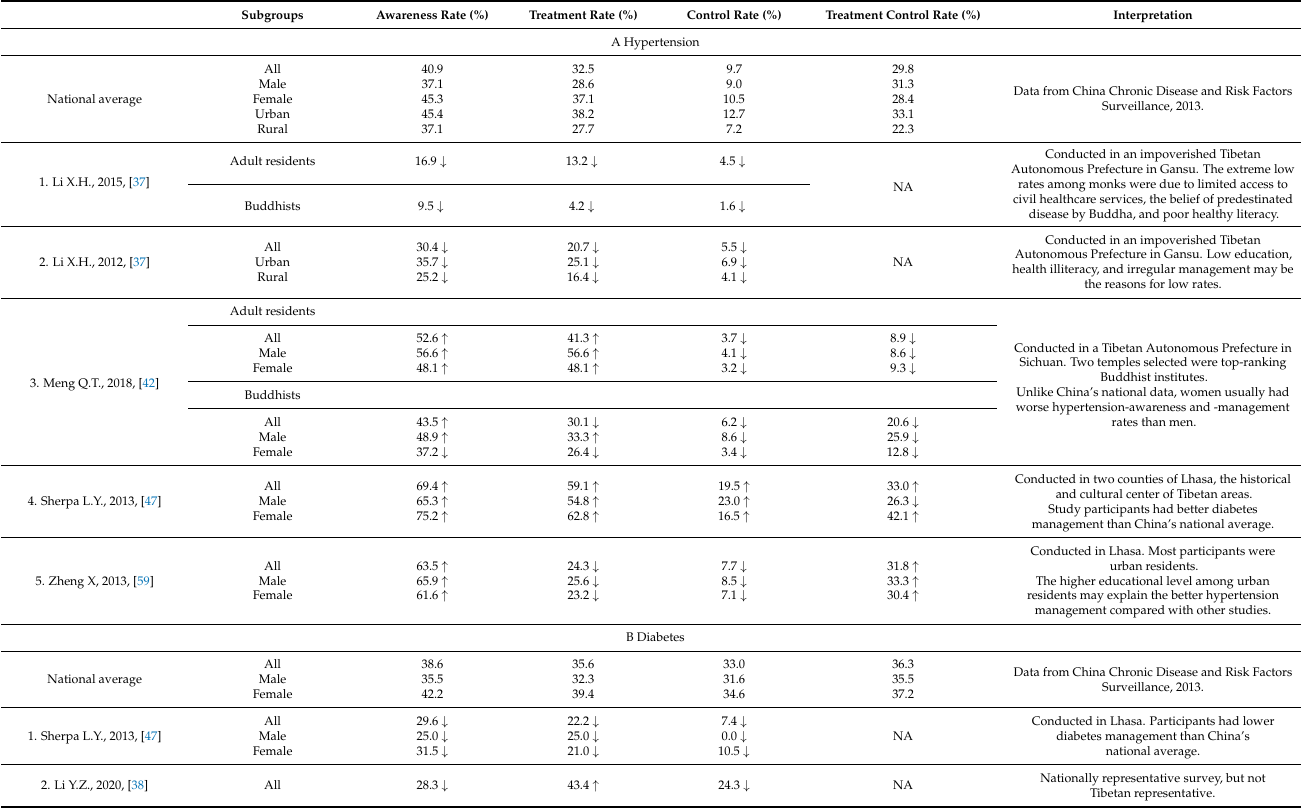
Table 1. Rates of awareness, treatment, and control of hypertension and diabetes among Tibetan population compared with national average in